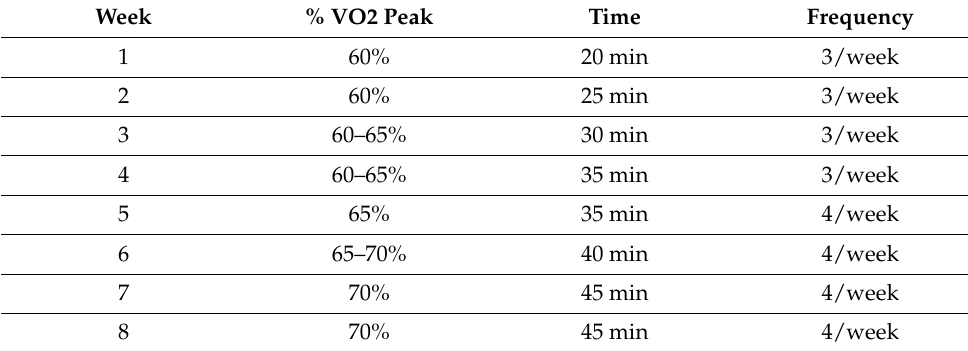
Table 4. Exercise training